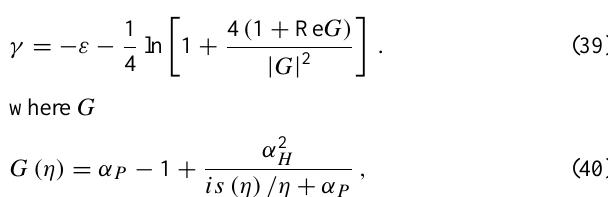
Figs. 3a and c with solid line. The imaginary part of x 0 ,